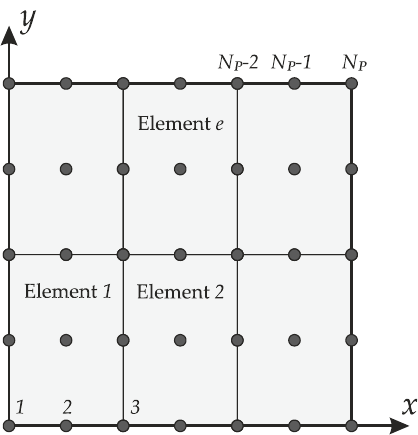
Figure 3. Example of a discrete domain and node numbering.